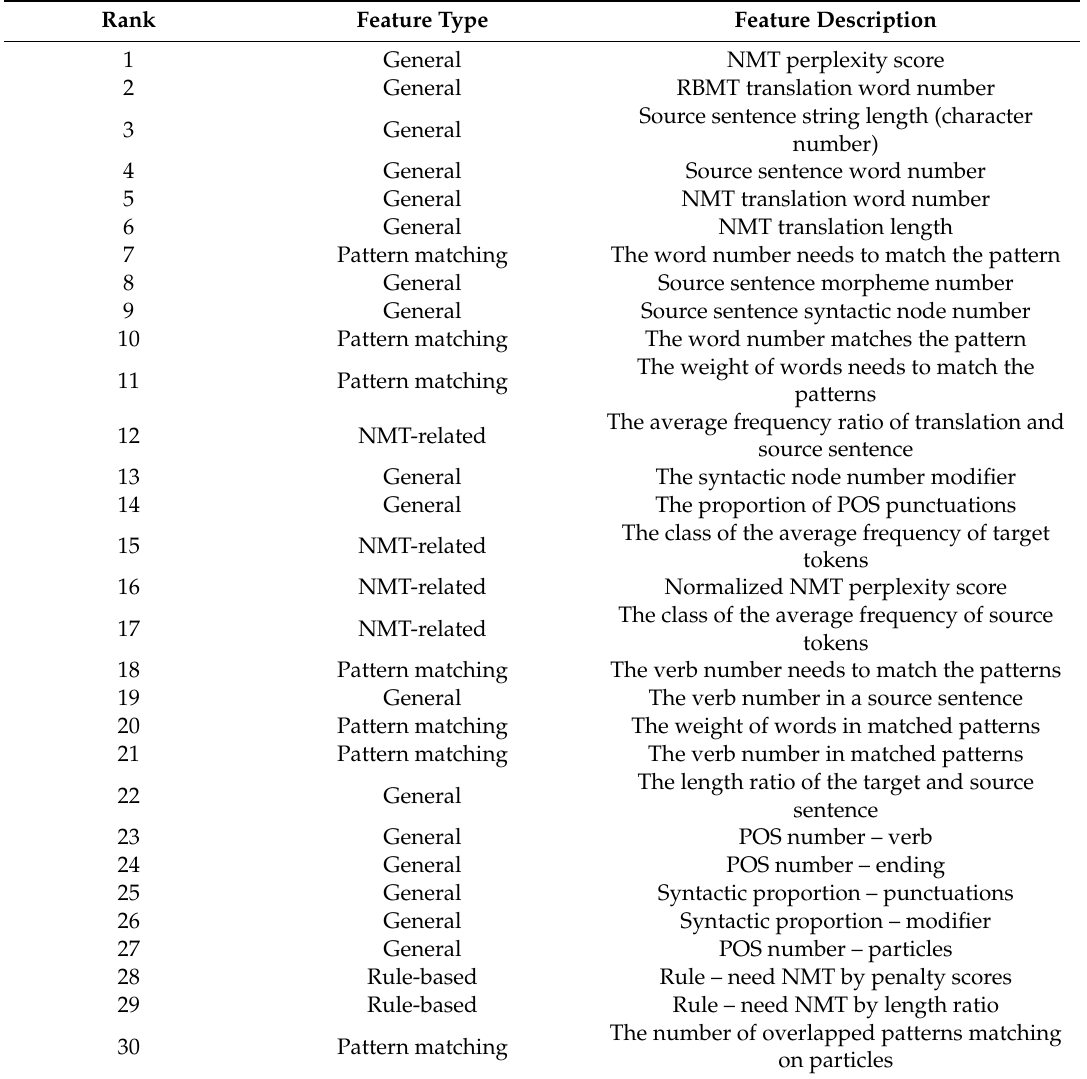
Table 5. Feature